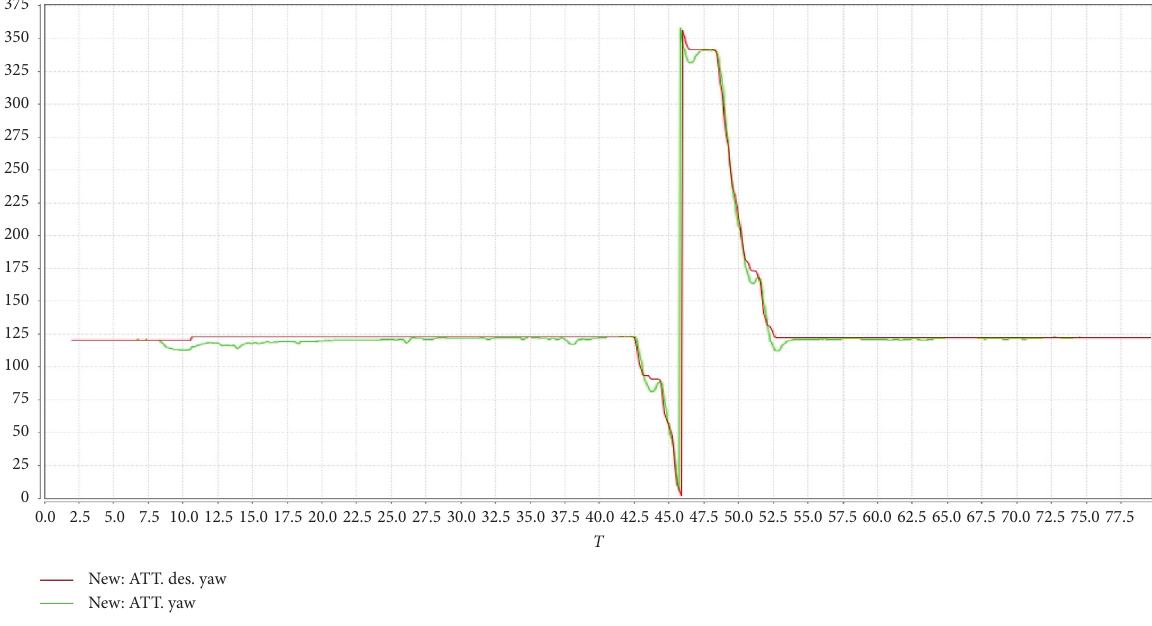
Figure 13: Actual flight yaw angle graph.